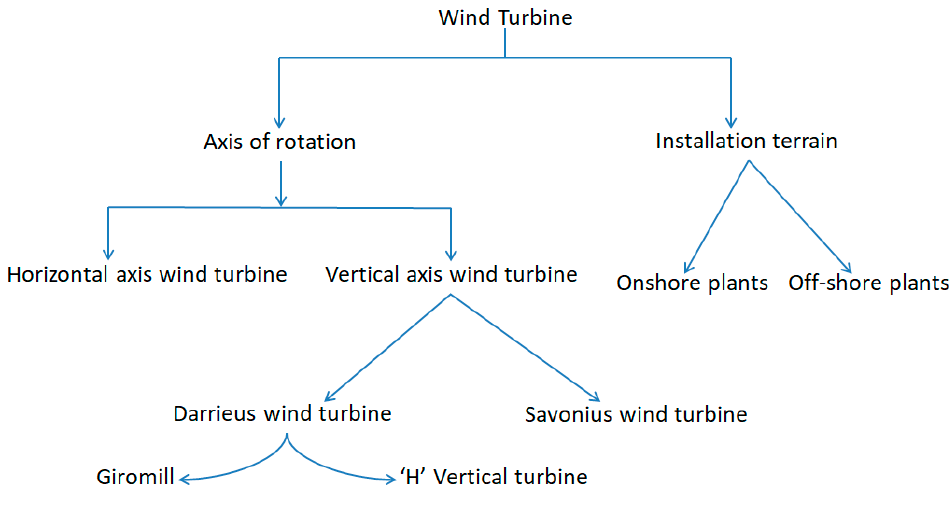
Figure 6. Wind turbine classifications.